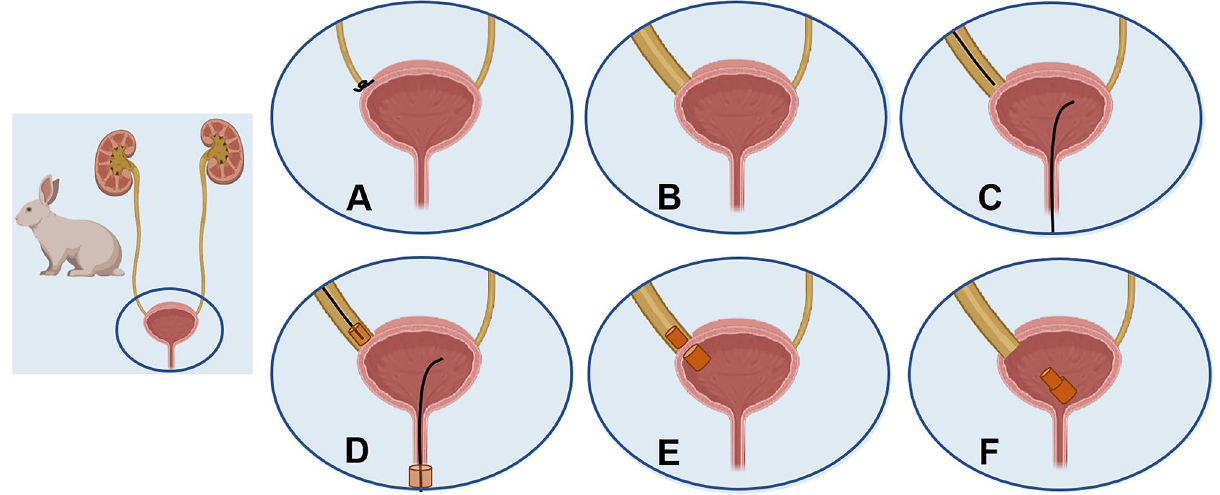
Figure 2. Schematic illustration of the surgical procedure. ( A ) Ligation of the right ureter. ( B ) Significant dilatation of the right ureter. ( C ) Insertion of the guide wire to the bladder and right ureter, respectively. ( D ) The daughter and parent magnets were placed along the guide wire into the right distal ureter and bladder, respectively. ( E ) The parent and daughter magnets are attracted together. ( F ) The anastomosis is